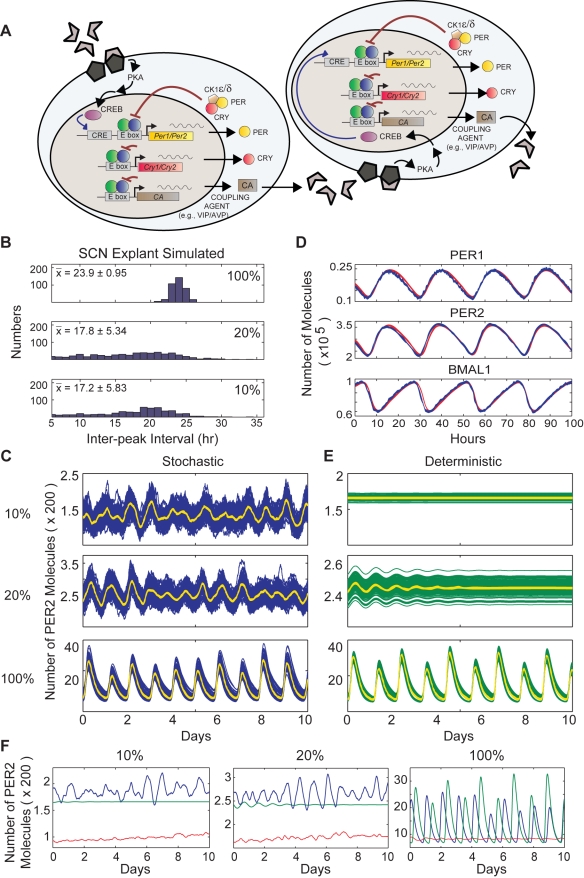
Modeling of intercellular coupling mechanisms in a population of simulated SCN cells.(A) Computational simulations applying coupling mechanisms to a population of 100 cells. The CLOCK:BMAL complex activates production of coupling agents (CA; e.g., VIP). CAs are secreted and act on cell-surface receptors on other SCN neurons, triggering cell-signaling pathways. The final product of the receptor pathways, CREB, binds to a CRE element upstream of PER. In the proposed mechanism, CREB forms a dimer and binds to a CRE element, which leads to activation of PER. CRY can repress CREB-activated PER production. (B) Histograms of average inter-peak intervals in a simulated population of coupled cells with 100%, 20%, and 10% of total WT BMAL. These results show that as the amount of BMAL is decreased, the average period decreases and the variance in the period length increases. Calculations were done as in Figure 1E. (C) The output of PER2 protein from stochastic simulations with 10%, 20%, and WT (100%) amounts of BMAL. The population averages from each simulation are plotted in yellow. (D) The proposed model was simulated for a single cell using both stochastic and deterministic approaches. In the limit of a large number of molecules, the results of the stochastic simulations (blue) agreed with the deterministic simulations (red) when the same parameter values were used. Shown in this figure are concentrations of total PER1, total PER2, and free BMAL1 proteins. Results would be similar for any other protein complex or mRNA in the proposed model. (E) The output of PER2 protein from deterministic simulations of a coupled population of oscillators with 10%, 20%, and WT (100%) amounts of BMAL. The population averages from each simulation are plotted in yellow. Contrary to the stochastic simulation (as shown above in 5C), the deterministic simulation could not sustain rhythmicity by coupling alone. (F) The average PER2 out from a simulated population of 100 cells. The left panel is the mean population rhythm of noisy coupled cells (stochastic; blue), coupled deterministic cells (green), and noisy uncoupled cells (red) at 10% of total WT BMAL. The middle and right panels are the same as the left panel, except that the cells are at 20% and 100% of total WT BMAL, respectively. These results indicate that neither noise alone nor coupling alone is sufficient to produce rhythms in a population of BMAL1-deficient cells. In addition, it is evident that coupling elevates the average number of PER molecules.